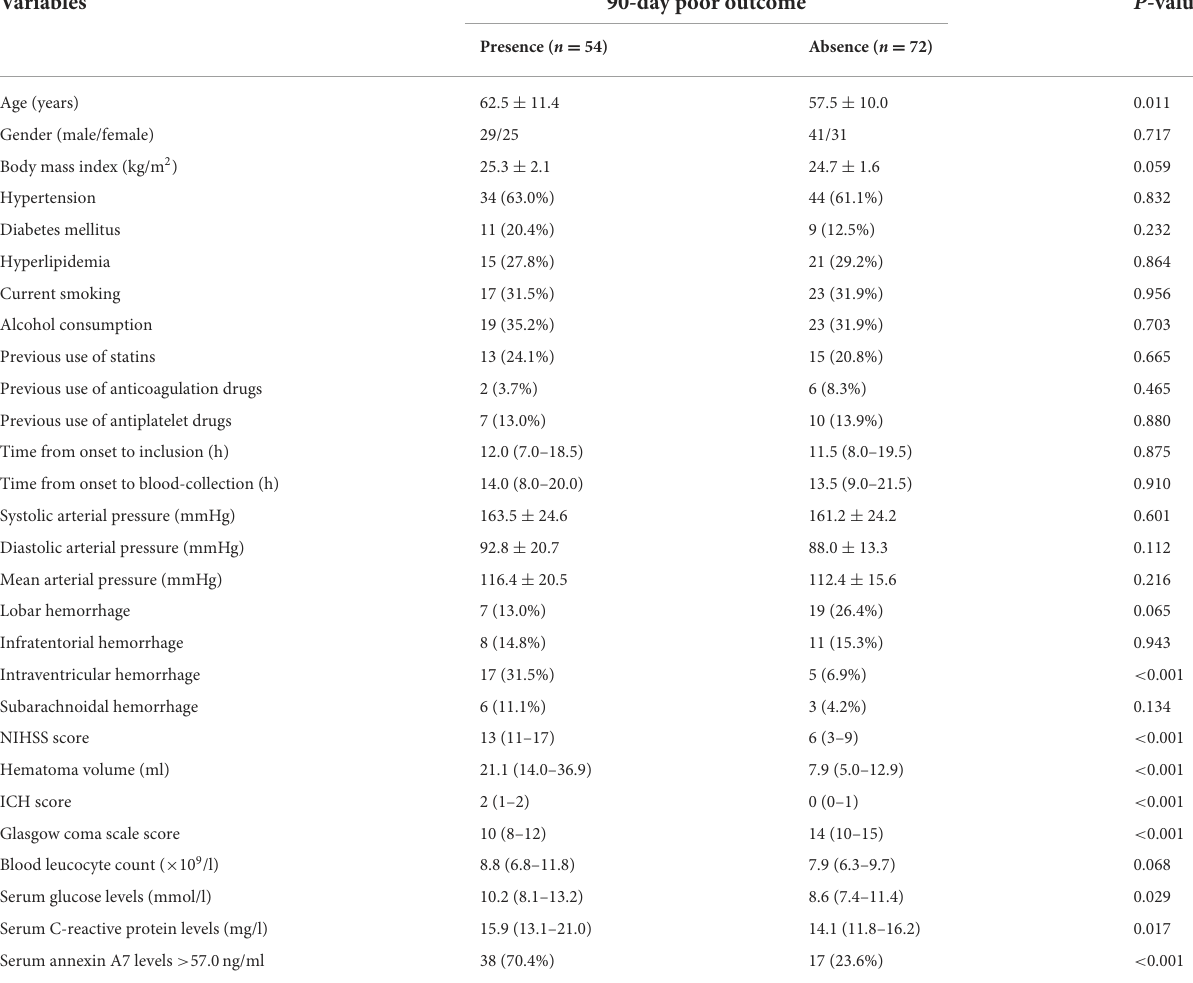
TABLE 4 Pertinent factors of 90-day poor outcome after acute intracerebral hemorrhage.